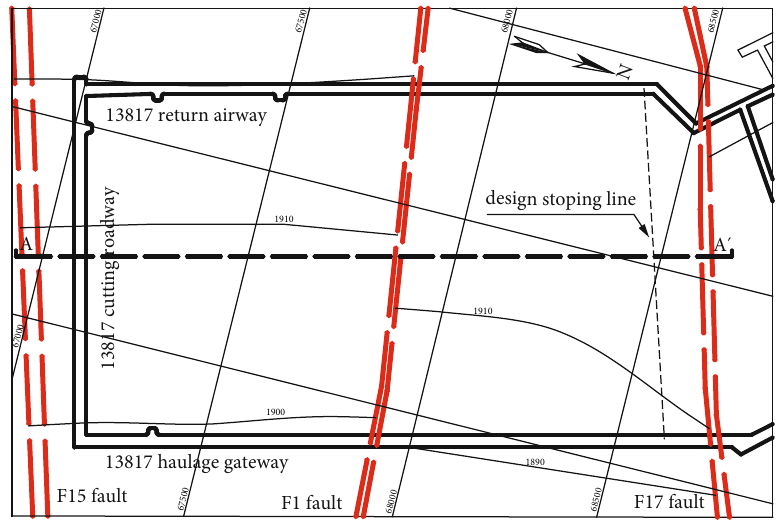
Figure 3: 13817 mining face mining